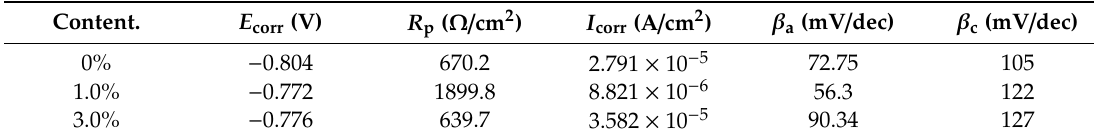
Figure 10. Tafel curve of coatings with di ff erent black paste contents. Table 3. E ff ect of black paste content on corrosion resistance.